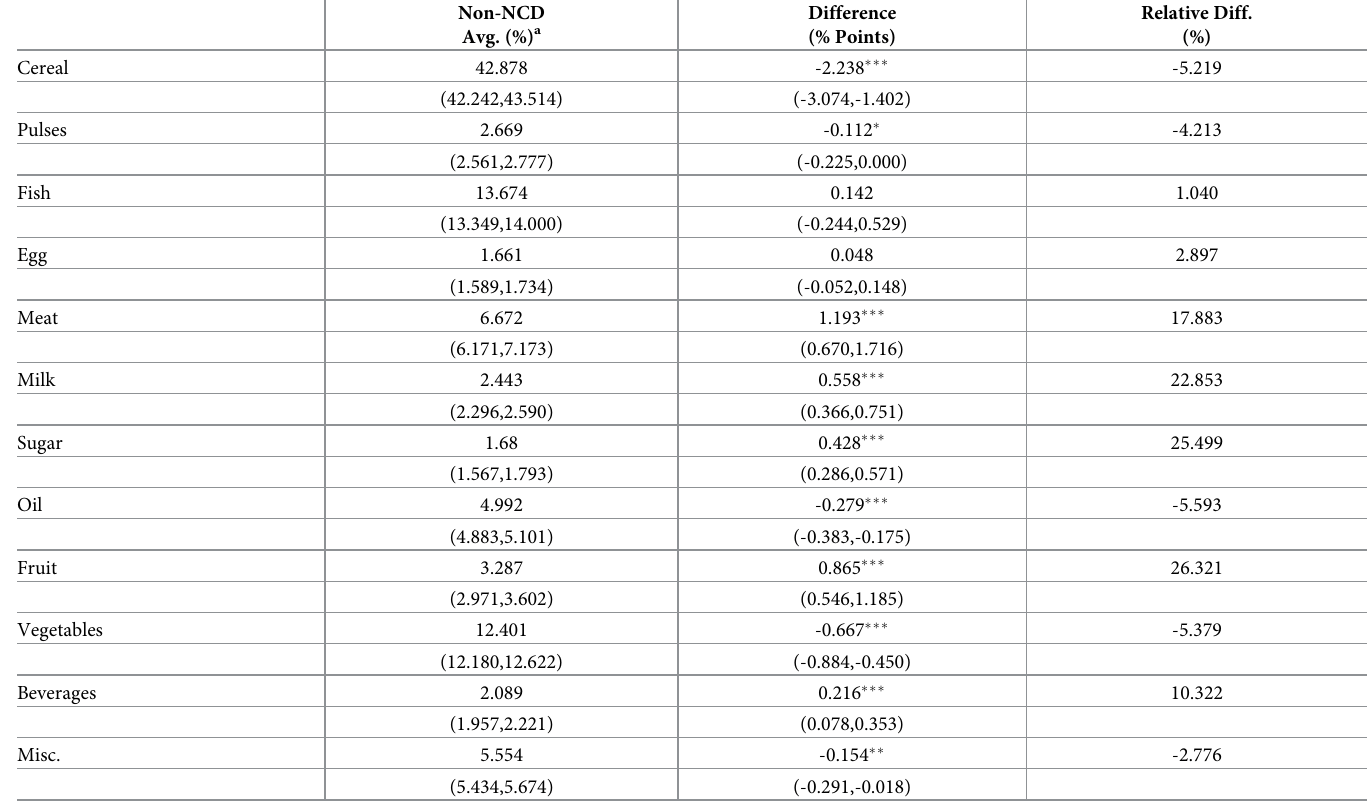
Table 5. Unadjusted differences in food expenditure categories between NCD & non-NCD households.